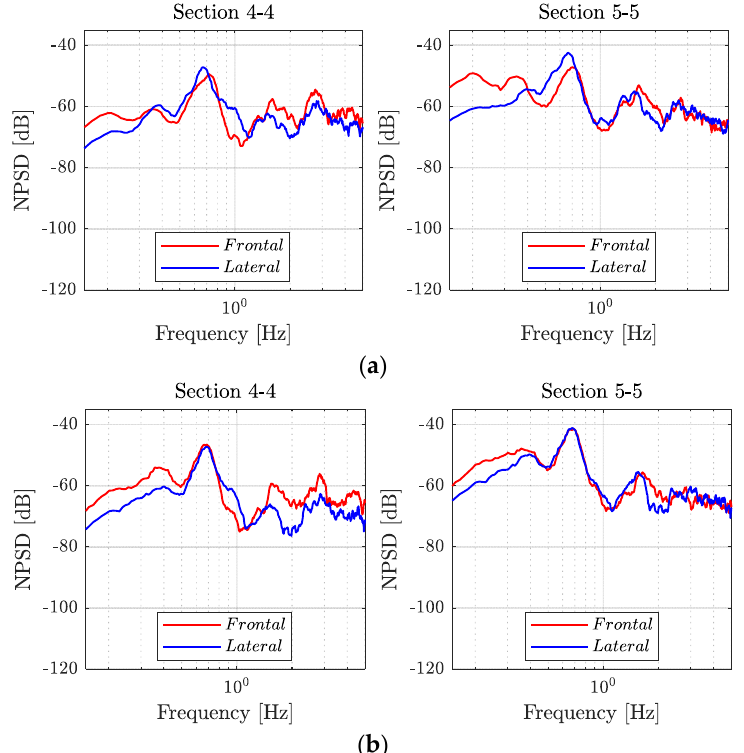
Figure 9. The NPSDs of the two branches in the lateral direction (x) and in the frontal direction (y) during Test #3 ( a ) and Test #8 ( b ).